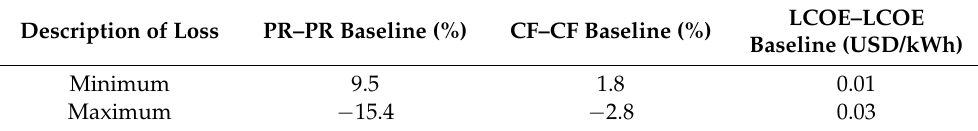
Table 7. Differences in performance ratio, capacity factor and LCOE of the maximum and minimum cumulative effect of system-related, system-related derate factors and module efficiency compared with the baseline for a 50